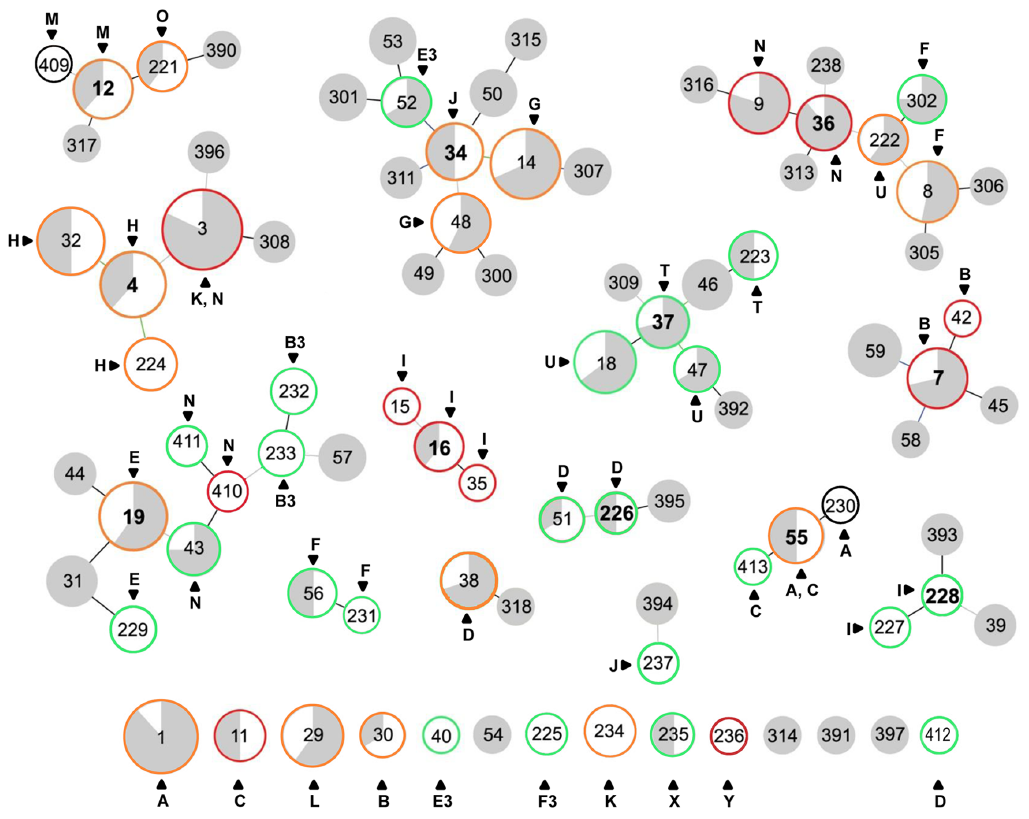
Figure 1. A population snapshot of B.burgdorferi in the northeastern and midwestern United States and Canada. The snapshot comprises of 88 STs (420 human and tick samples) and was created by goeBURST v1.2 using data from this study and the previously published data sets downloaded from http://borrelia.mlst.net/[7,41–43]. Circle size and color correspond to MLST sample size and the source, respectively. Gray, strains found in ticks; white, strains found in humans. Colored lines connecting STs indicate descending order of certainty; black lines are inferred without tiebreak rules, blue lines are inferred using tiebreak rule 1 (number of SLV), and green lines are inferred using tiebreak rule 2 (number of DLV). STs connected by a black line are single locus variants and STs connected by gray line are double locus variants. The inferred founders of clonal complexes are numbered in bold. STs found in patients with localized infection are outlined in green, those found in patients with disseminated infection are outlined in red, those found in both patients with localized and patients with disseminated infection are outlined in orange and those found in patients with undetermined clinical status are outlined in black. STs that are not outlined were only found in ticks. The ospC major groups are shown for all 53 STs which were found in humans.